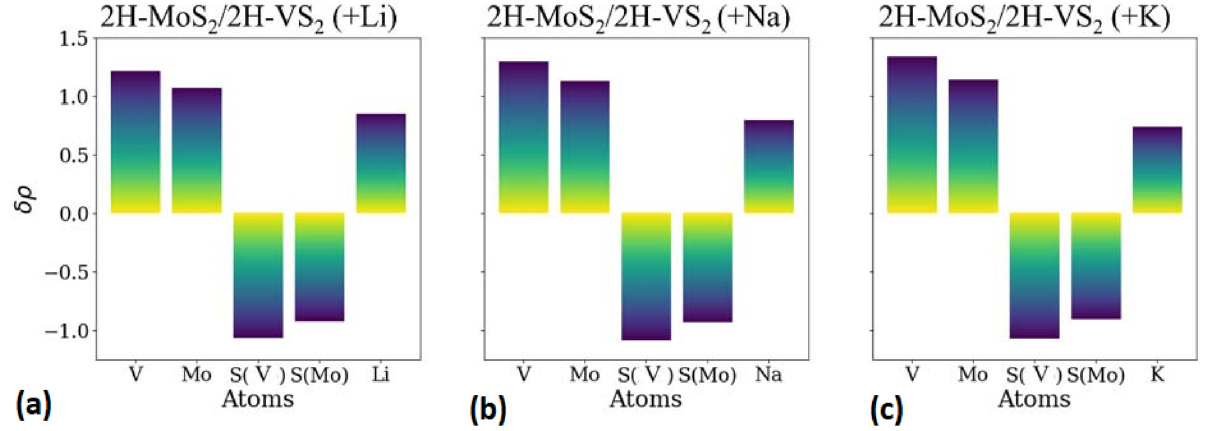
Figure 6. Charges transferred from different atoms in ( a ) Li-ion, ( b ) Na-ion and ( c ) K-ion intercalated 2H-MoS 2 /2H-VS 2 heterostructures (alternating layers of VS 2 and MoS 2 ) computed using Bader